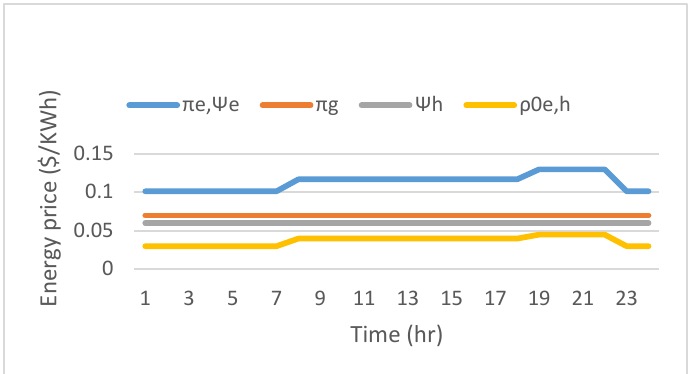
Figure 7. Energy prices for the 1st year.